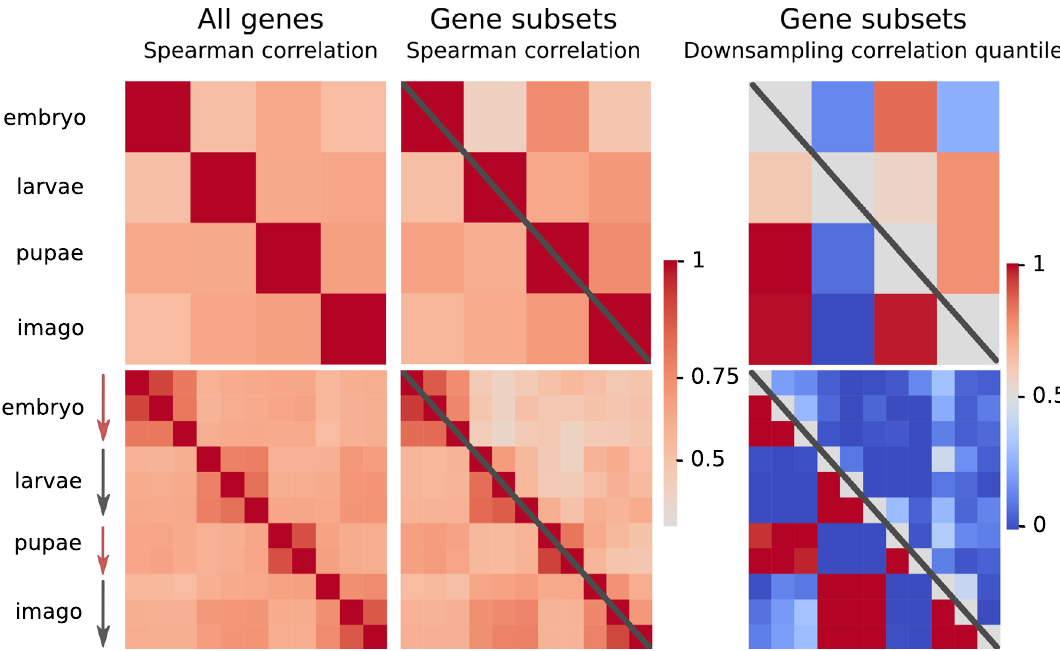
Figure 2. Pairwise correlation analysis for O. furnacalis (top) and T. castaneum (bottom). Sequential stages of development are depicted on both axes for each plot. The Spearman correlation coefficients were calculated for each pair of samples in each species: brighter cells correspond to higher correlation coefficients (left and middle). Symmetric matrices for the correlation coefficients for all genes are shown on the left. Correlation coefficients for the development-associated gene subset (the upper triangle, above the diagonal, for each species) and the metabolism-associated subset (the lower triangle, below the diagonal, for each species) are shown in the middle column. The results of random sampling analysis (see Methods) considering the development-associated gene subset (the upper triangle for each species) and the metabolism-associated gene subset (the lower triangle for each species) are given in the right column: high quantile values yields statistical support to the observed correlation being higher than expected for a random gene